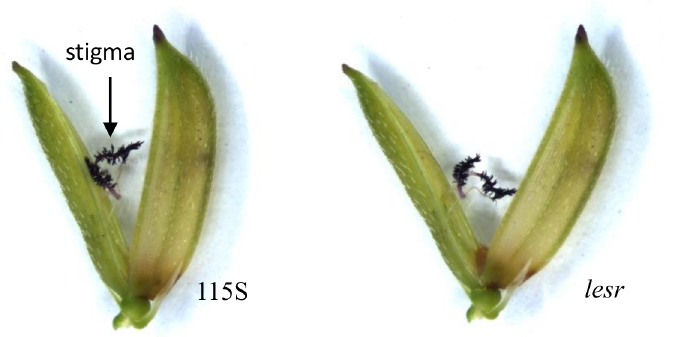
Fig 1. The stigma phenotype of lesr mutant.